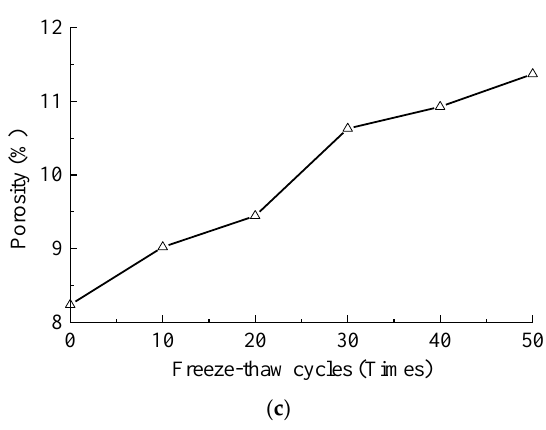
Figure 2. Variation rules of basic physical parameters of concrete specimens under freeze-thaw conditions. ( a ) Mass loss rate; ( b ) Volume growth rate; ( c ) Porosity.